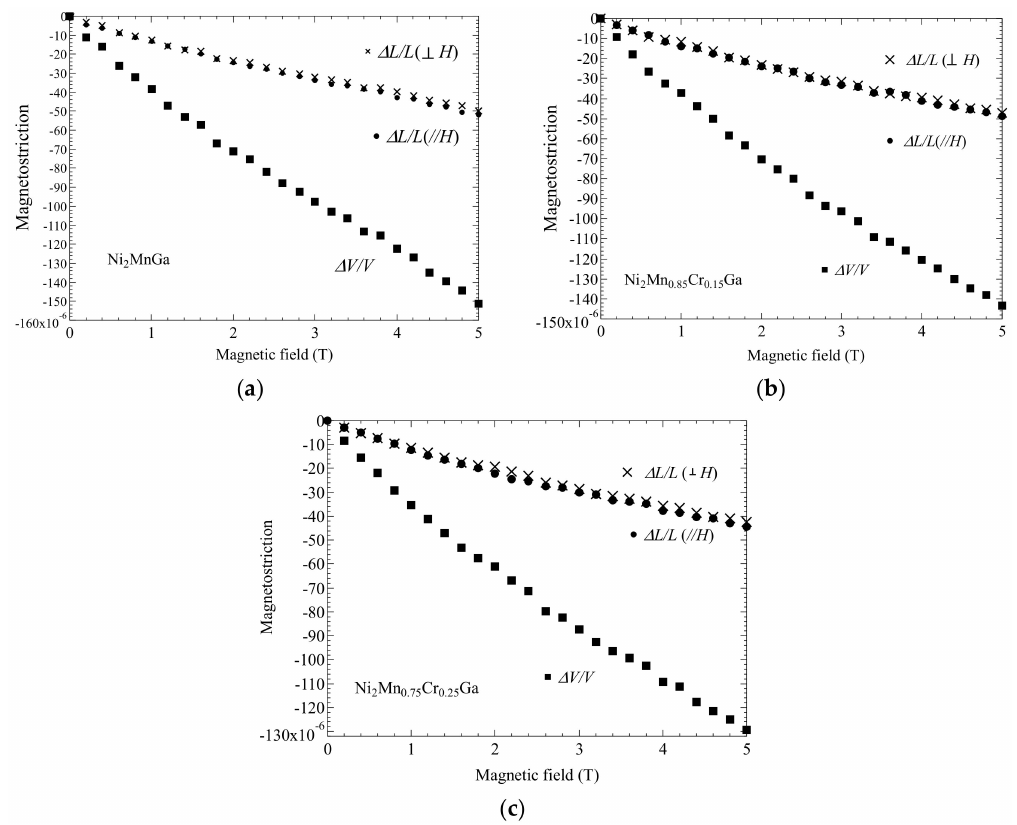
Figure 4. Magnetic field dependence of magnetostriction for ( a ) x = 0.00, ( b ) x = 0.15, and ( c ) x = 0.25 at T ∆ L / L ) // in ( a ) were obtained from Ref. [16]. T. Sakon et al. J. Appl. Phys. C . Data of ( 2018 , 123 , 213902, with the permission of AIP Publishing. doi:10.1063 / 1.5036558. Title: “Forced magnetostriction of ferromagnetic Heusler alloy Ni 2 MnGa at the Curie temperature”. Available on line: https: // aip.scitation.org / doi / 10.1063 / 1.5036558. (accessed on 6 Nov.